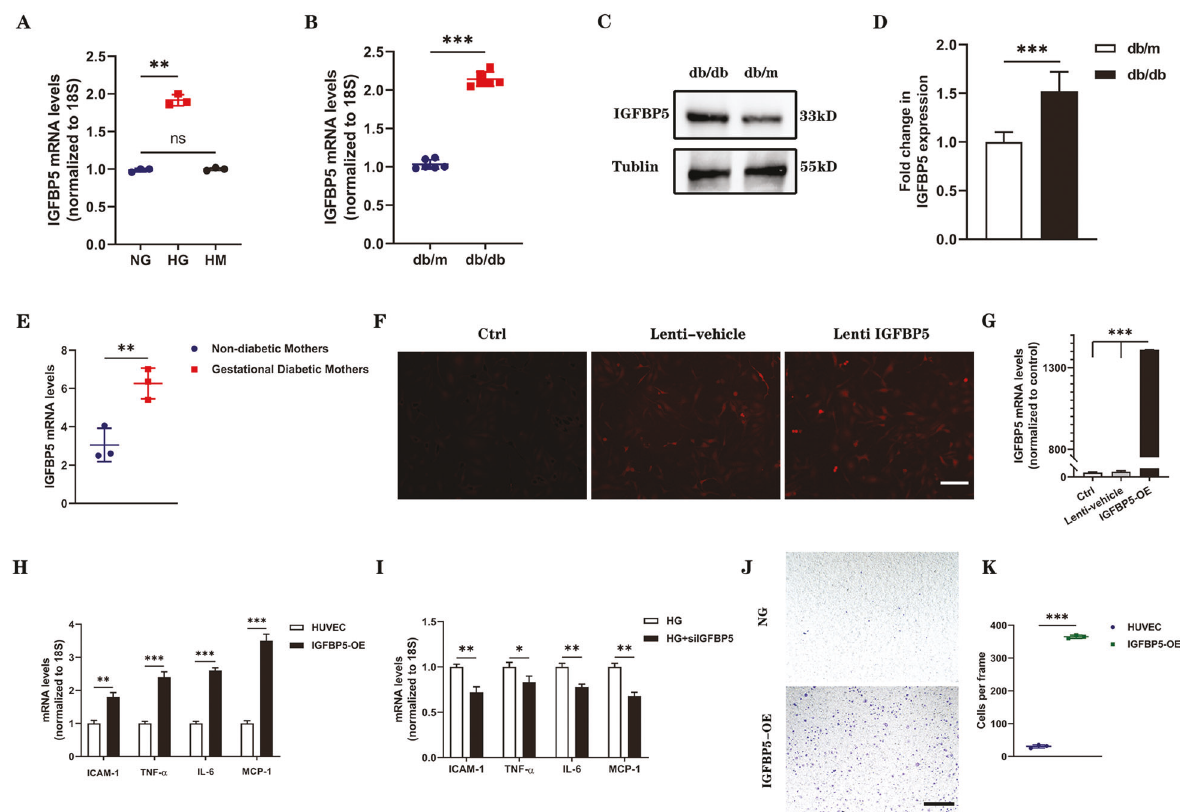
Fig. 1 IGFBP5 expression was increased in DKD mice and promoted endothelial in fl ammation. A RT – PCR analysis of IGFBP5 mRNA levels in NG- or HG-challenged HUVECs. n = 3. B IGFBP5 mRNA was determined by RT – PCR in the kidney tissues of db/db and db/m mice. n = 6. C , D Western blot analysis and densitometric quanti fi cation of IGFBP5 protein levels in the kidney lysates of db/m and db/db mice. n = 6. E RNA-sequencing analysis of IGFBP5 expression in HUVECs isolated from gestational diabetic mothers and non-diabetic mothers. n = 3. F A stable IGFBP5 overexpression (IGFBP5-OE) HUVEC line was established using lentiviral infection and an IGFBP5 overexpression sequence. Auto fl uorescence (red) showed successful transfection. Scale bar, 100 μ m. G Expression of IGFBP5 mRNA in IGFBP5-OE HUVECs compared with the control. n = 3. H RT – PCR analysis of the mRNA levels of ICAM-1, TNF- α , IL-6, and MCP-1 in IGFBP5-OE and control cells under NG conditions. n = 3. I RT – PCR analysis of the mRNA levels of ICAM-1, TNF- α , IL-6, and MCP-1 in siIGFBP5-treated HUVECs under HG conditions. n = 3. J Migration of THP-1 cells cocultured in Transwell systems with IGFBP5-OE or control HUVECs under NG conditions. Scale bar, 100 μ m. K Statistical analysis was performed by counting the number of migrated cells in different groups. n = 3. The data are shown as the mean ± SD in all statistical graphs. * P < 0.05, ** P < 0.01, *** P < 0.001; ns, no signi fi